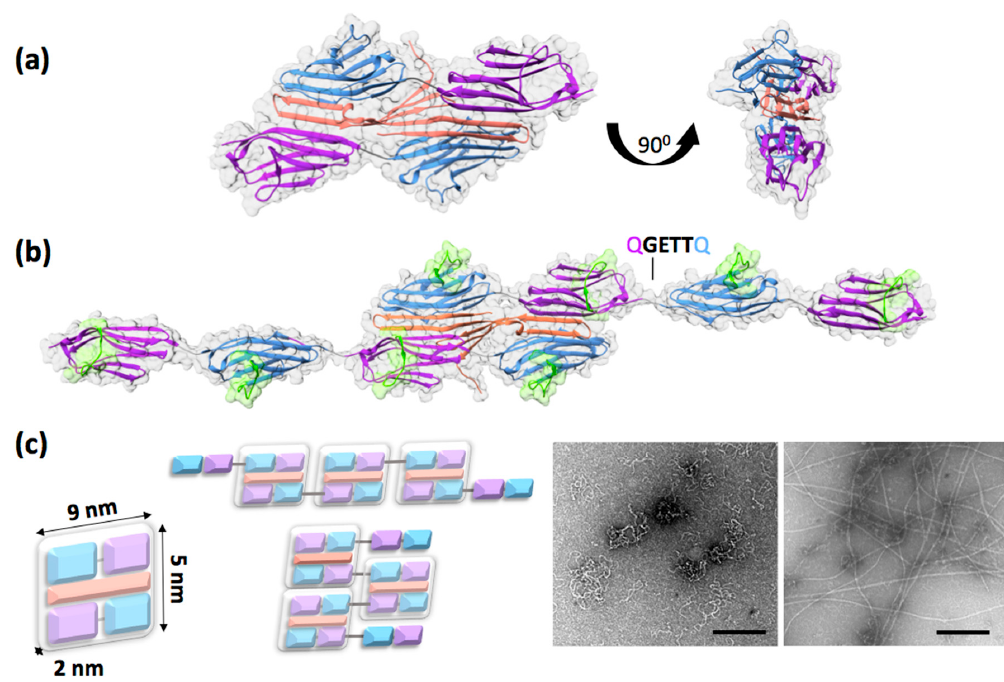
Figure 1. ( a ) Crystal structure of the naturally occurring Z1Z2/Tel complex (Protein Data Bank ID: 1YA5). Domain Z1 is shown in blue, Z2 in purple, and Tel is orange; ( b ) structural model of the Z1Z2-Z1Z2 tandem (Z 1212 ) generated by genetically fusing two Z1Z2 pairs using a QGETTQ engineered linker sequence. The model shows the proposed cross-linking of two Z 1212 units by a Tel molecule at the initial polymerization event. The CD loop serving as internal functionalization site for the grafting of exogenous peptide sequences onto the Z1 and Z2 Ig domains is highlighted in green; ( c ) schematic representation of the Z1Z2/Tel complex with its molecular dimensions (left), its predicted assembly modes (centre), and electron micrographs of the assembled polymer (right). Thin, curly fibers allegedly resulting from sequential tandem assembly can be seen interwoven with thicker, straighter formations possibly corresponding to perpendicular assemblies. Scale bars correspond to 500 nm (left image reproduced from [30] with permission).